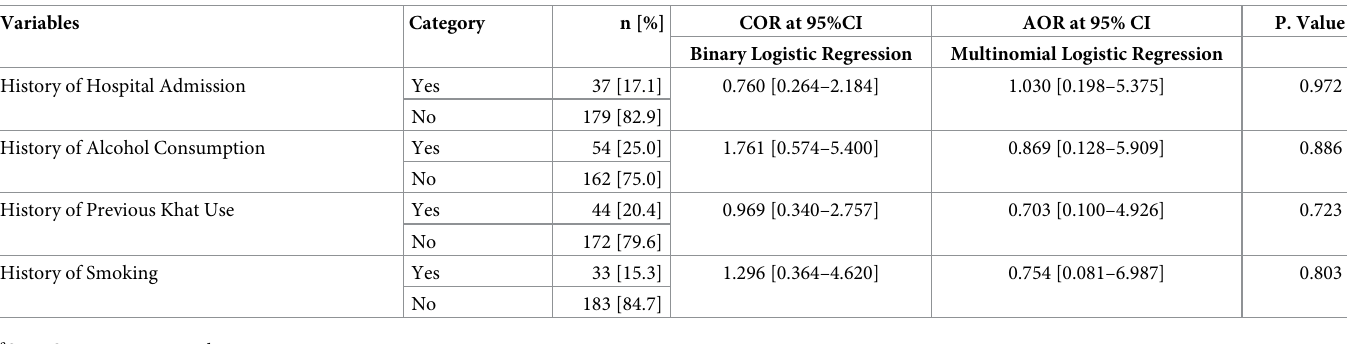
PLOS ONE | https://doi.org/10.1371/journal.pone.0277145 December30,